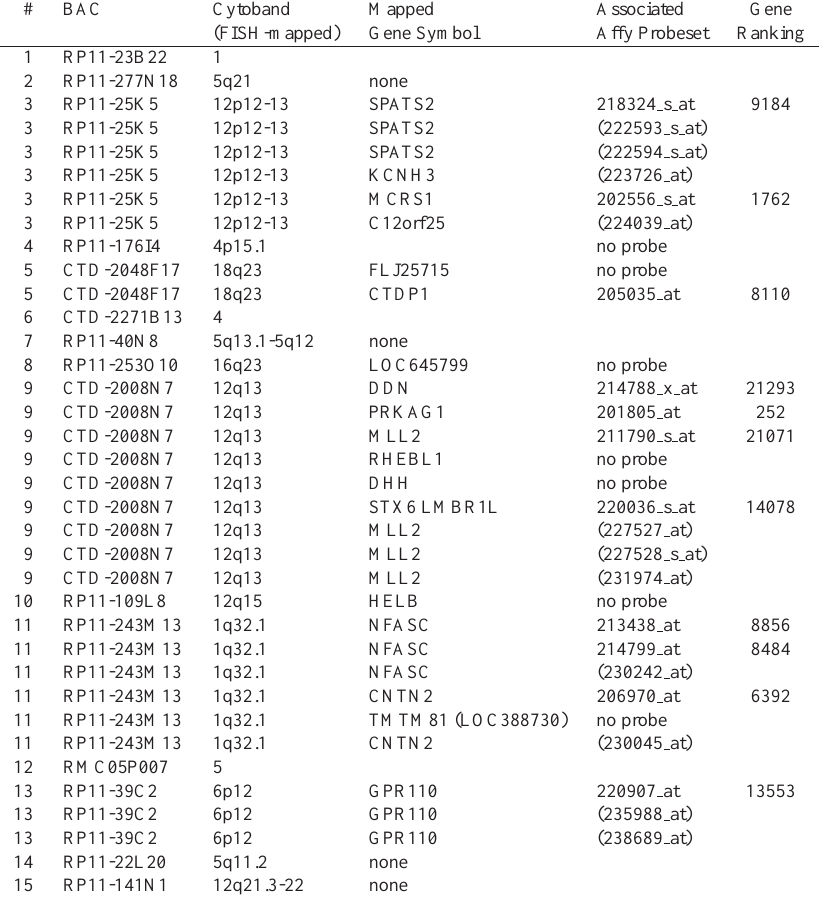
Table 4: Top-15 ranked BAC with the included genes. The Affy probesets in parentheses belongs to the Affymetrix U133B platform, and thus they are not present in the Chin06 dataset [4].